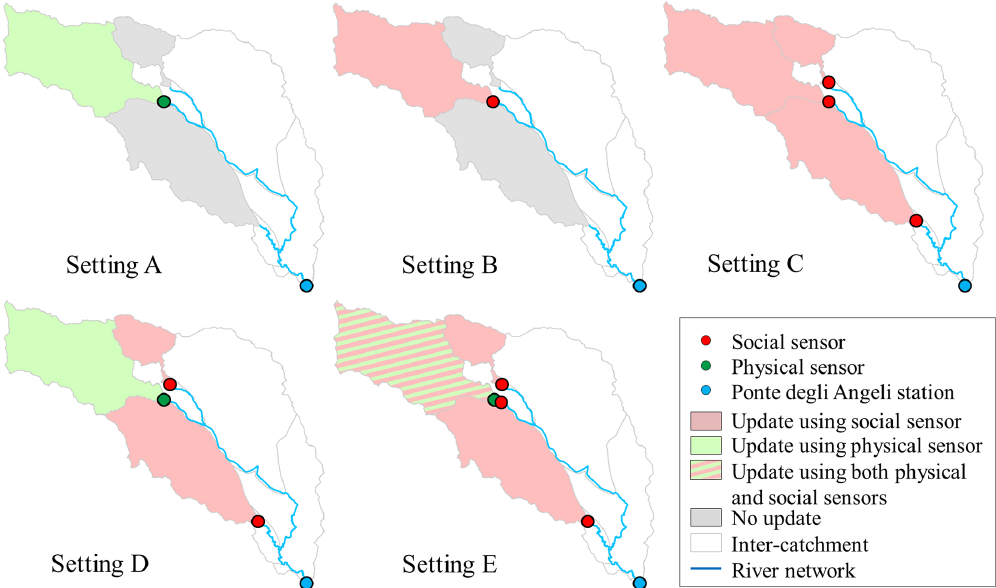
Figure 6. Experiment 2: characteristics of the five experimental settings (A to E) implemented within the Bacchiglione catchment: location of the social and physical sensors (dots), hydrological model update based on different sensors (coloured areas).